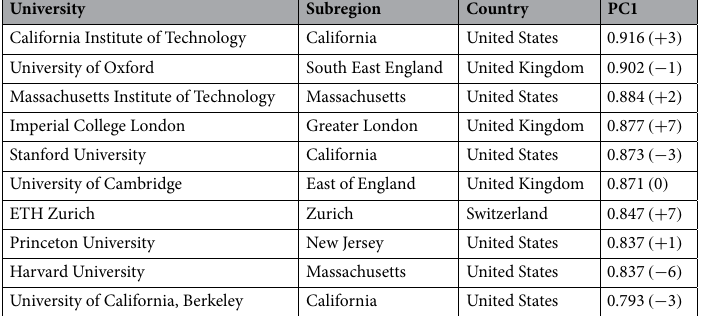
Table 2. Top ten universities in the ranking of the principal component PC1 associated to the THE overall score. In the last column, the number in round brackets indicates the position variation in the PC1 ranking with respect to the original one.